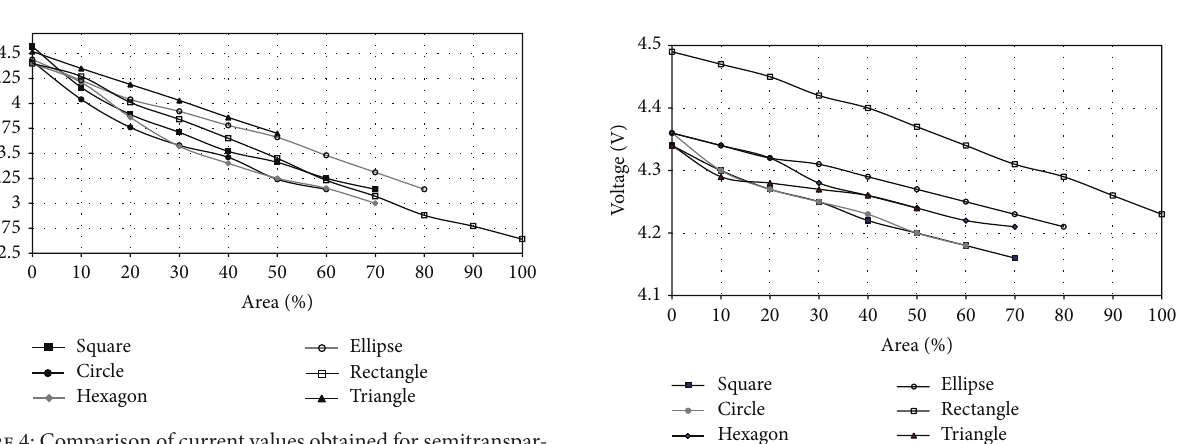
Figure 4: Comparison of current values obtained for semitranspar- ent areas on light source.